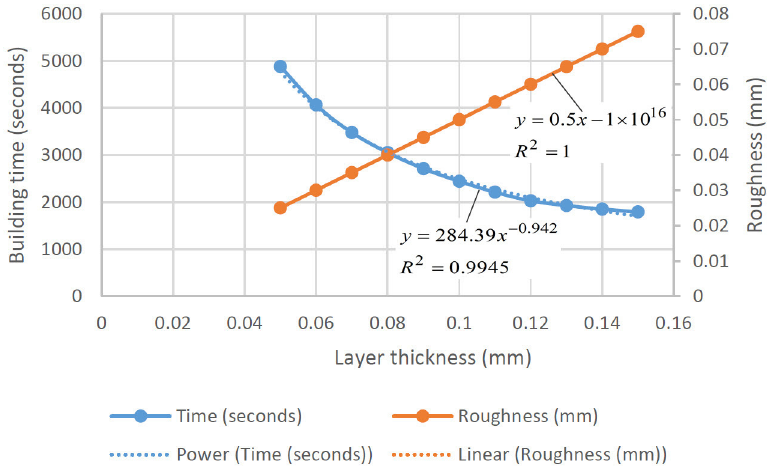
Figure 16. The effect of layer thickness on building time and roughness [102].